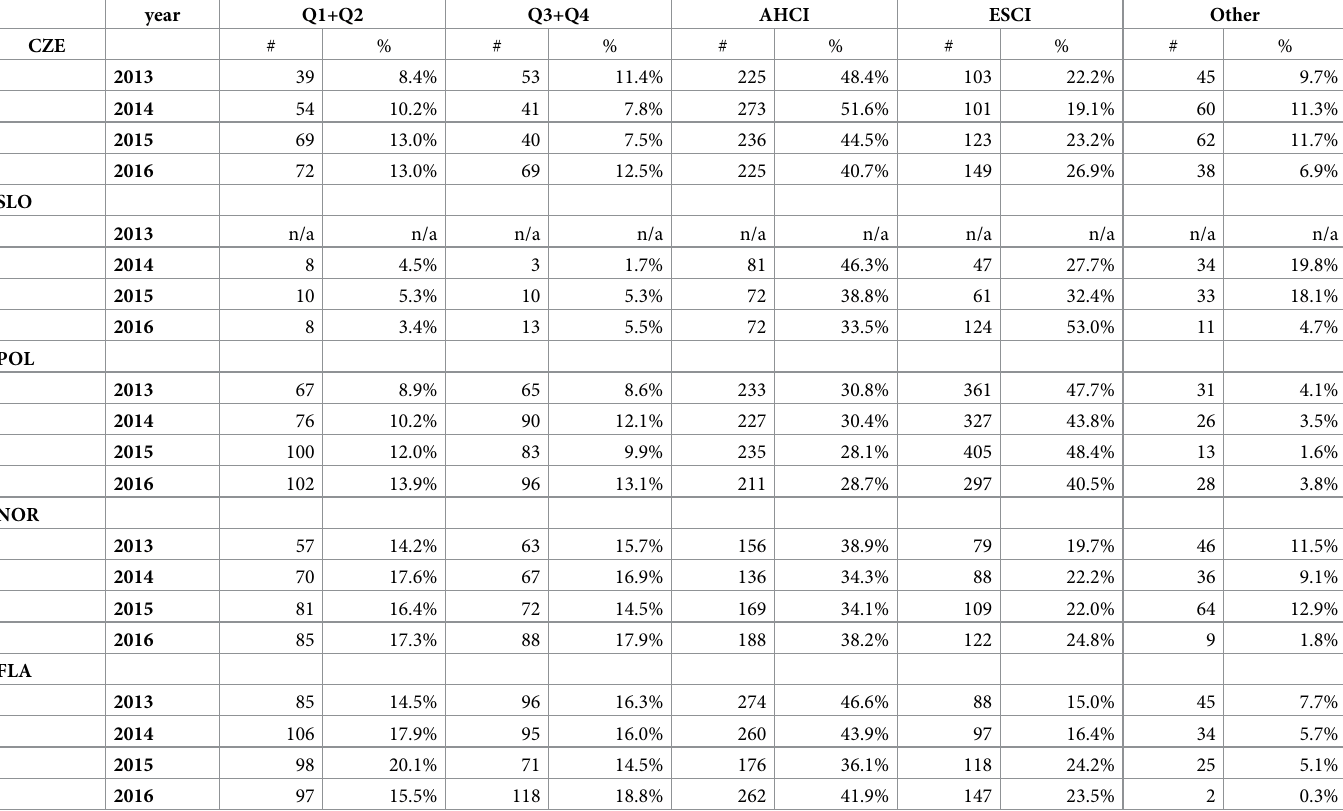
Table 3. Distribution of articles in WoS citation indexes–humanities.